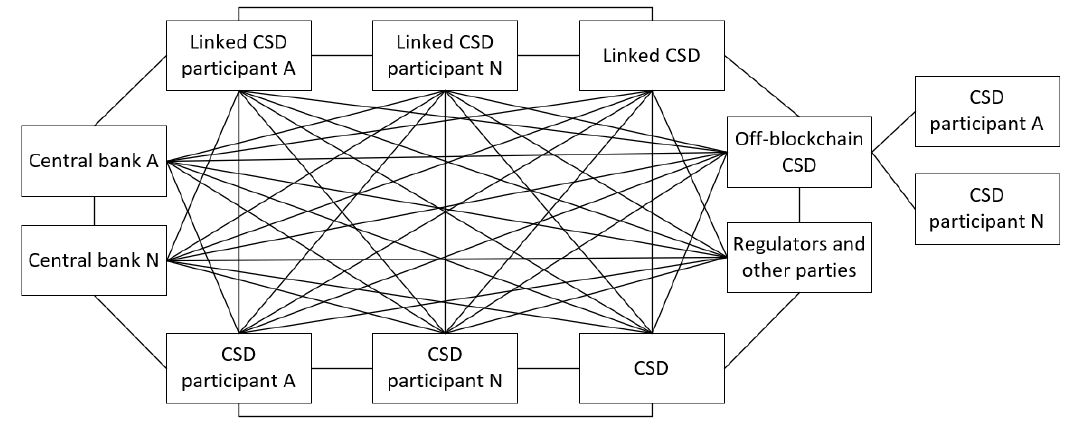
Figure 4. Proposed node linkage structure for securities settlement on blockchain (available also in